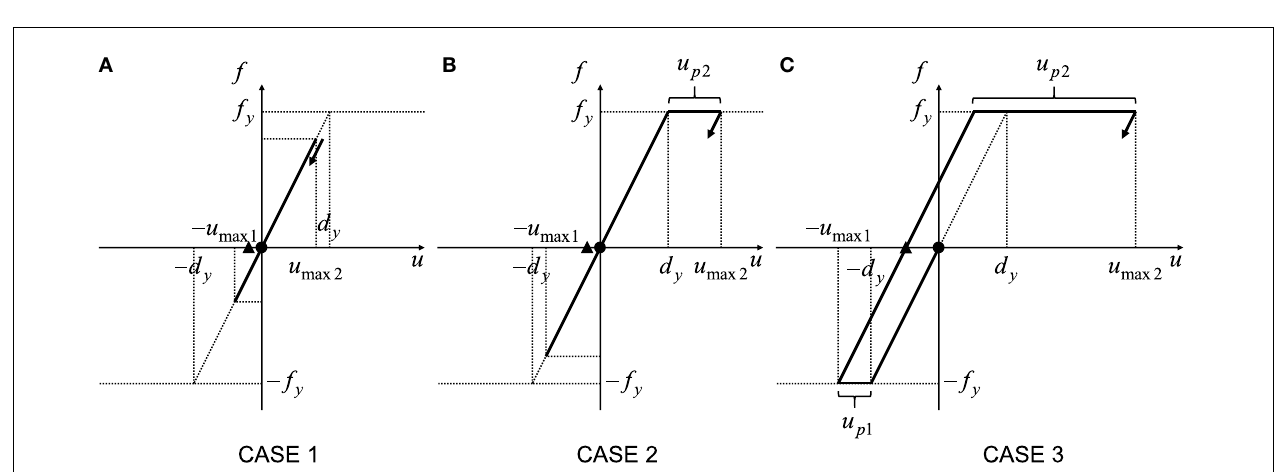
FIGURE 3 | Maximum deformation under double impulse based on energy approach: (A) Case 1: elastic response, (B) Case 2: plastic response only after the second impulse, and (C) Case 3: plastic response even after the first impulse ( (cid:15) : first impulse, N : second impulse) .